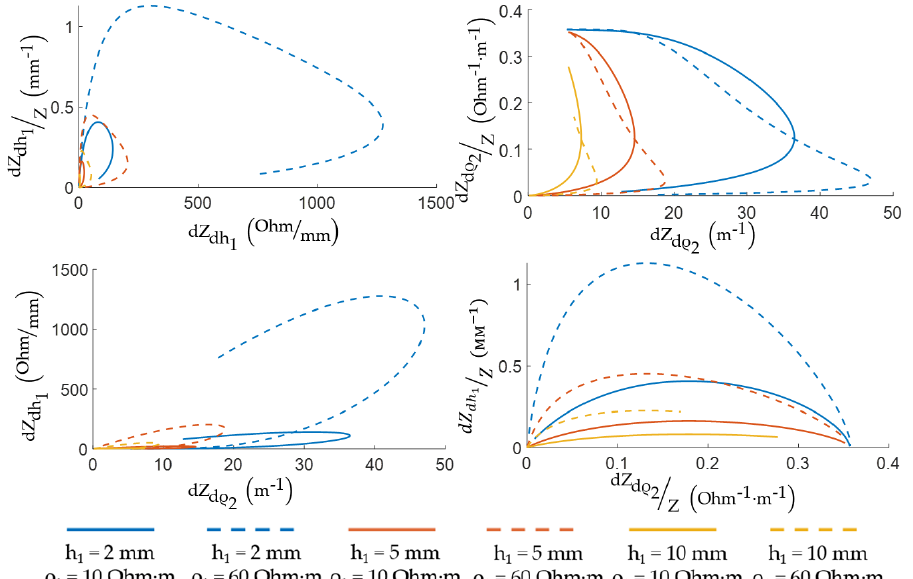
Figure 13. Pareto sets for EI sensitivity criteria.